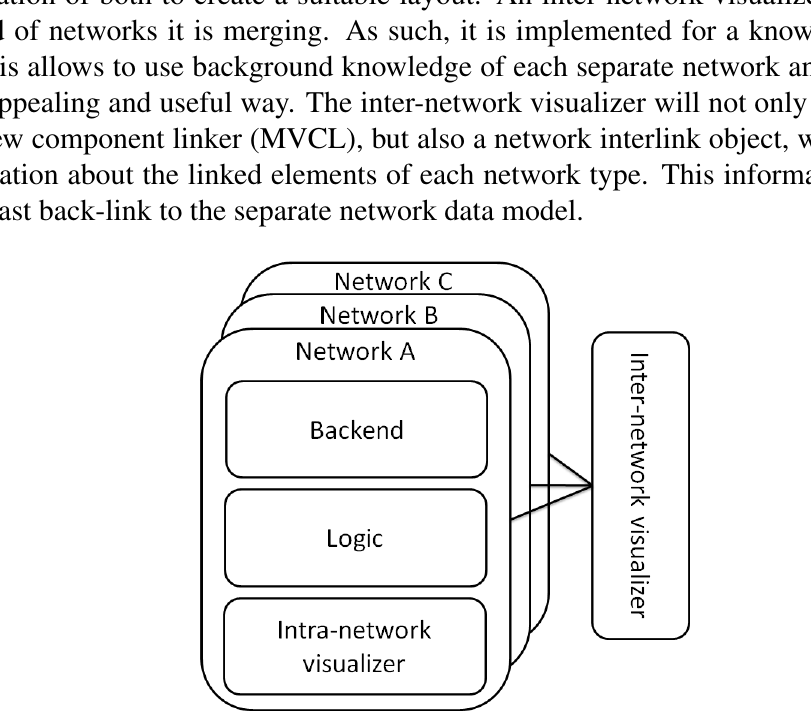
Figure 2: The intra-network and inter-network visualizer in the model